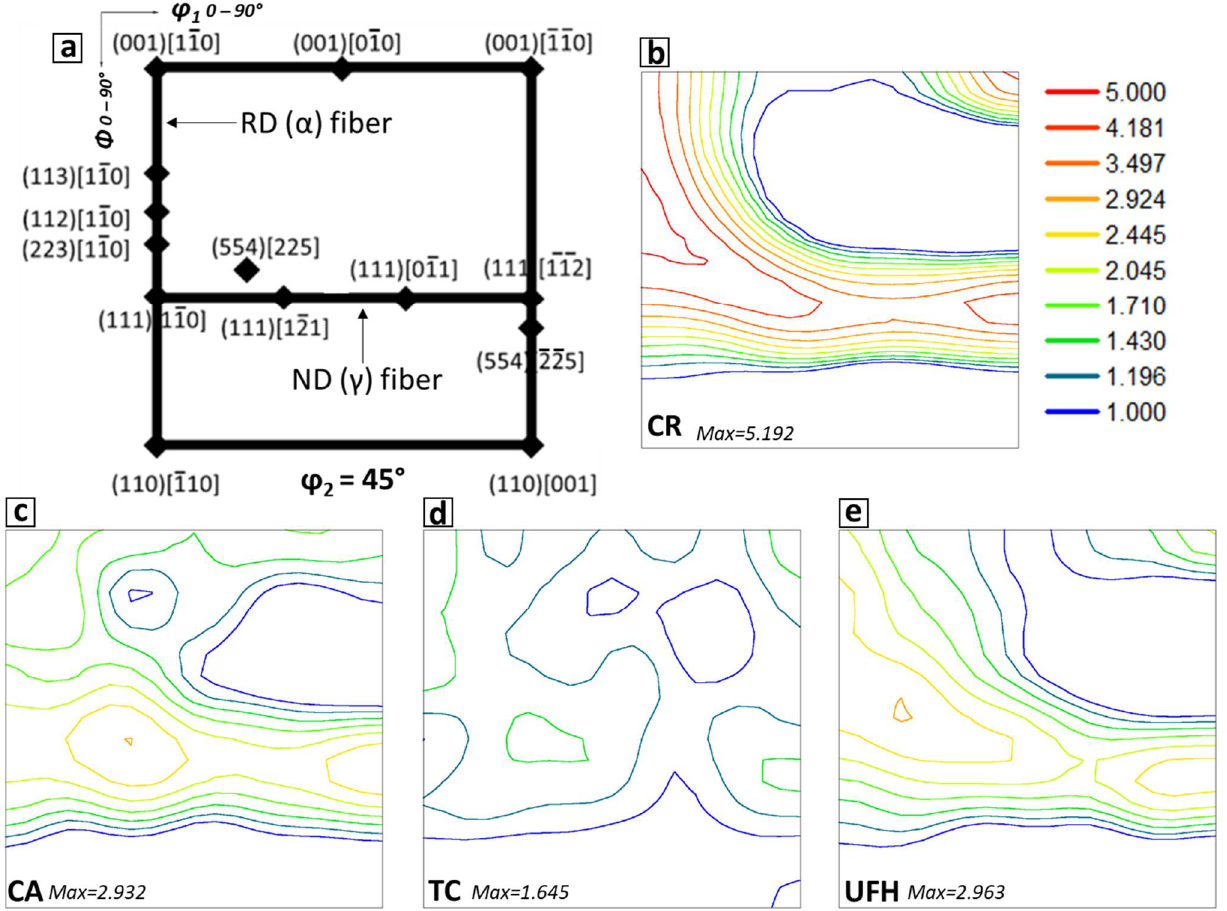
Figure 7. ODF at φ 2 = 45° section of the Euler space. ( a ) main texture components of rolled BCC crystals. ( b ) 70% cold-rolled material. ( c ) CA. ( d ) TC. ( e ) UFH. (Scanned area 22,500 µm 2 ).